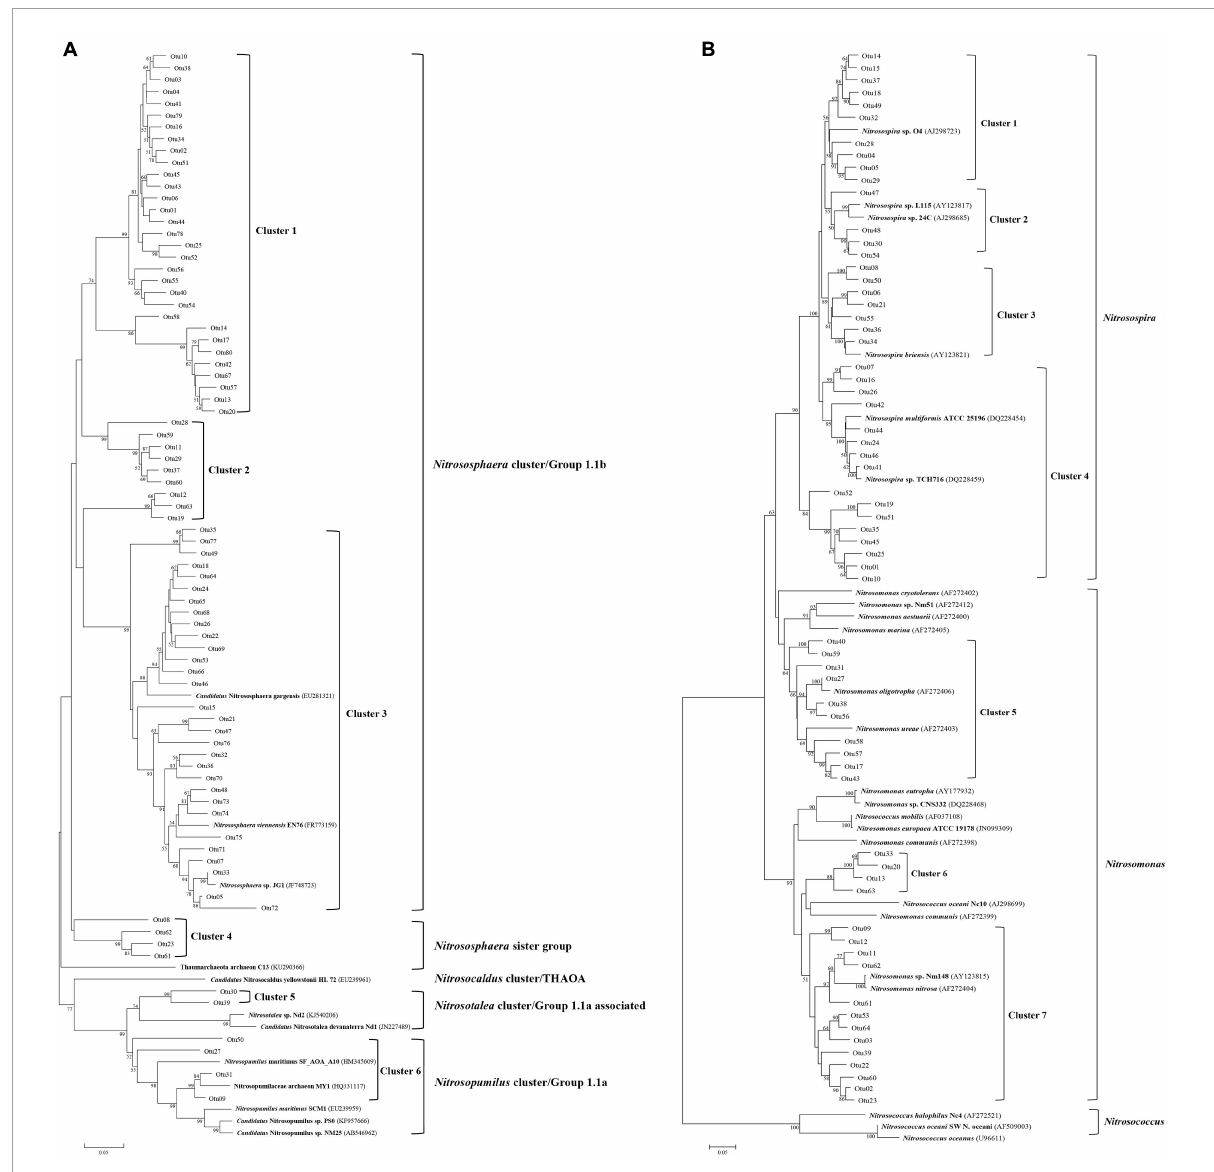
FIGURE3 Phylogenetic clusters of ammonia-oxidizing archaea (AOA) (A) and ammonia-oxidizing bacteria (AOB) (B) operational taxonomic units (OTUs) based on neighbor-joining analysis with known AOA and AOB taxa from GenBank. Numbers at the nodes indicate bootstrap support levels of 1,000 resampled datasets, with only those bootstrap values larger than 50% being